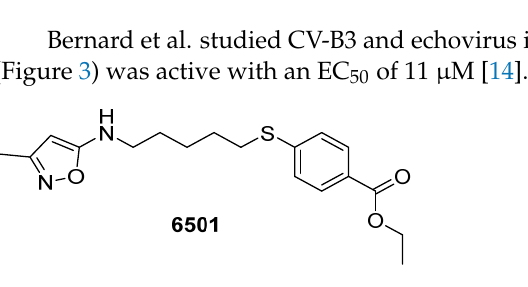
Figure 3. Chemical structure of compound 6501 .